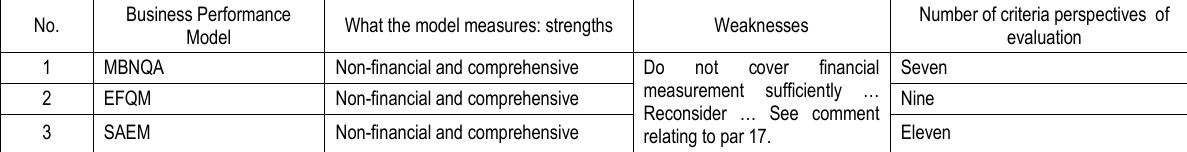
Table 1. Summary of selected management evaluation models